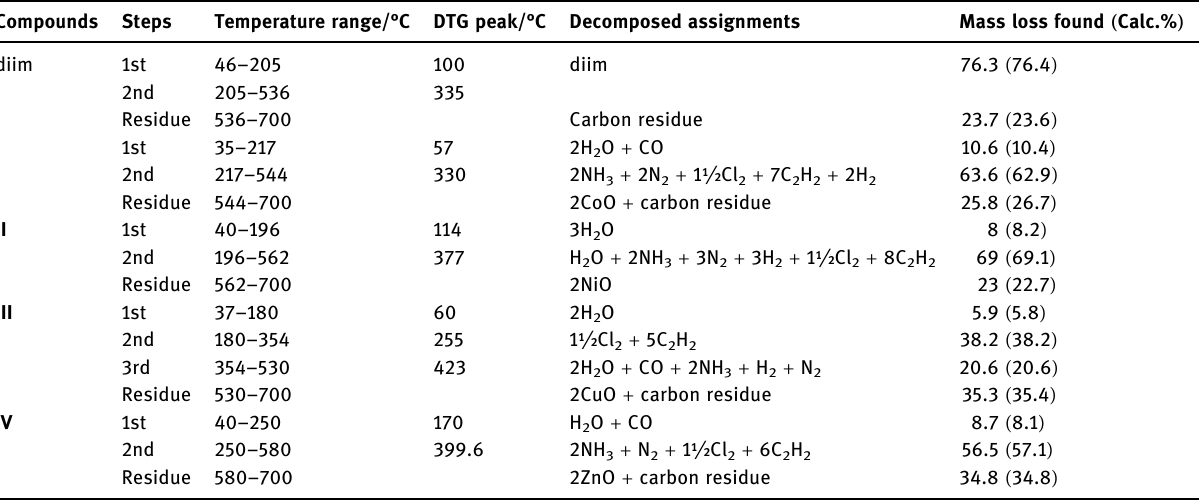
Table 3: Thermogravimetric data of the methoxy - diim and its metal complexes